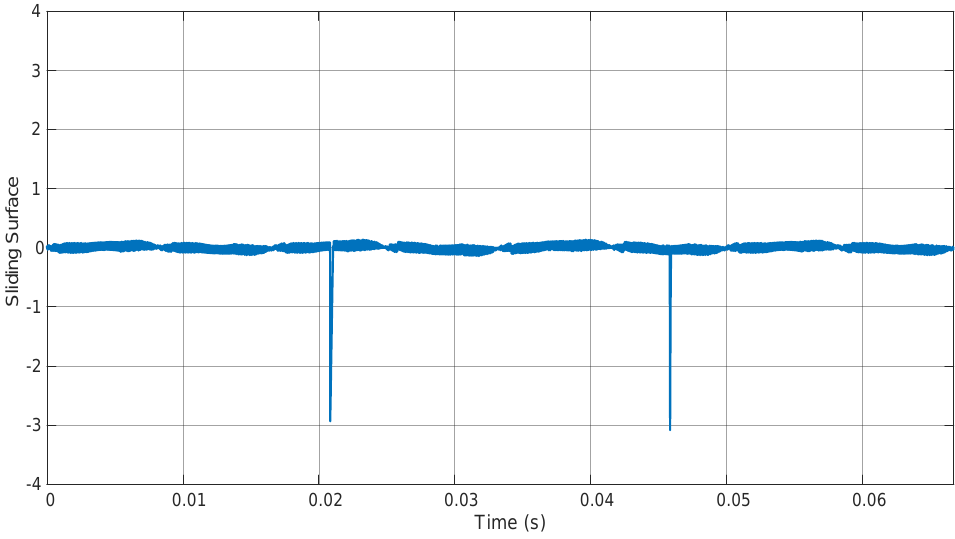
Figure 9. Tracking error between currents 𝑖 1∗ and 𝑖 1 .